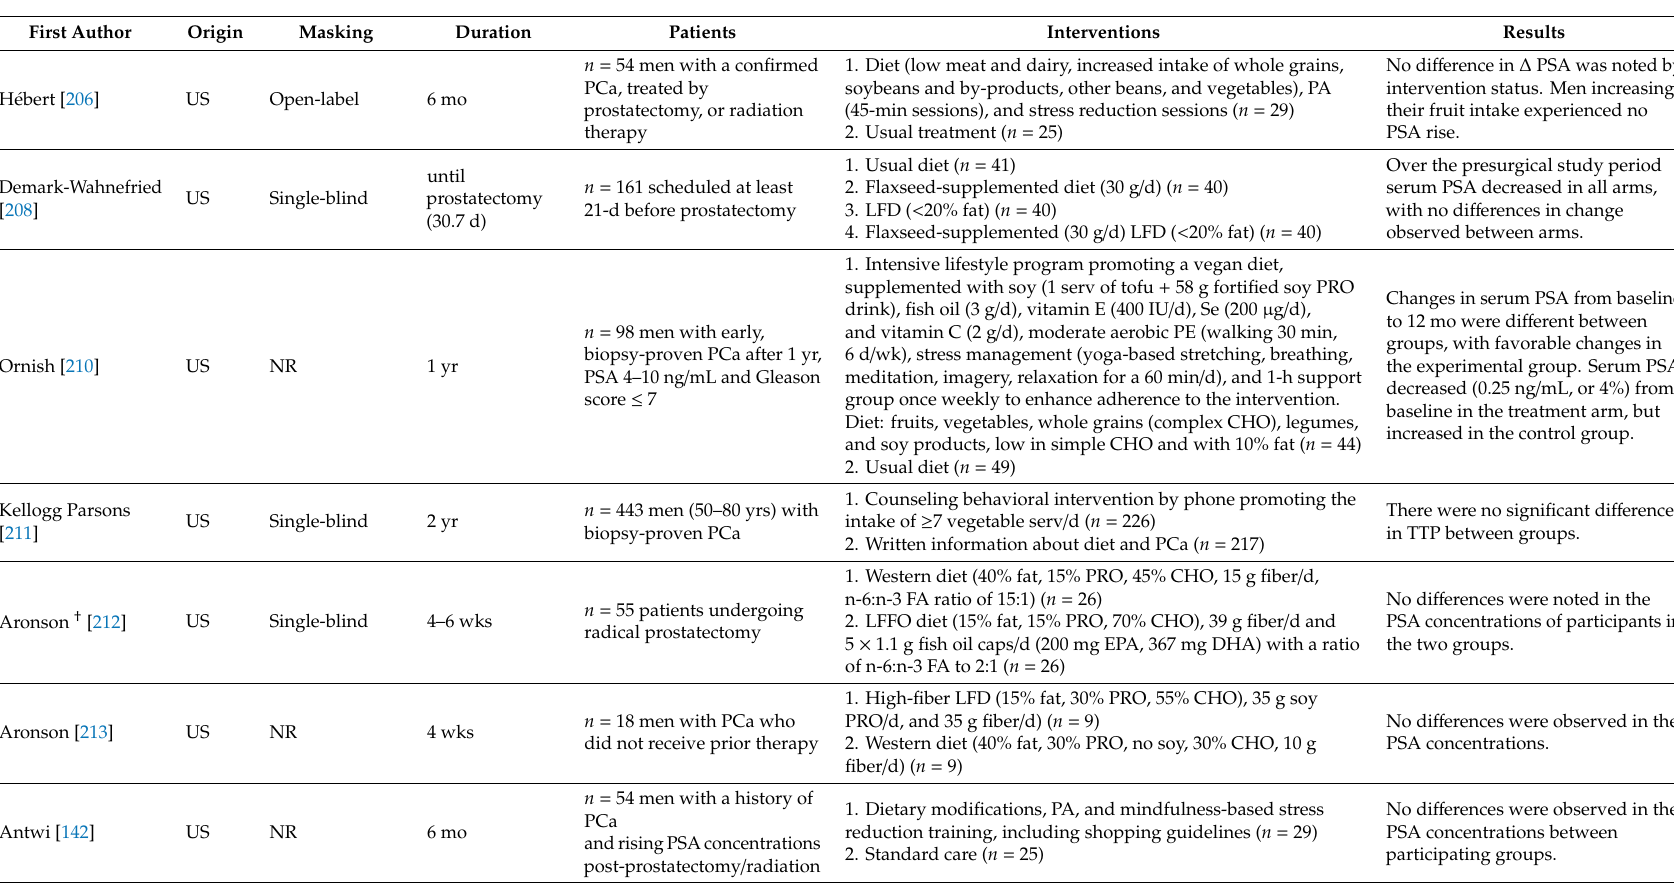
Table 11. RCTs examining the e ff ect of dietary patterns on serum PSA concentrations among men with PCa or increased PCa